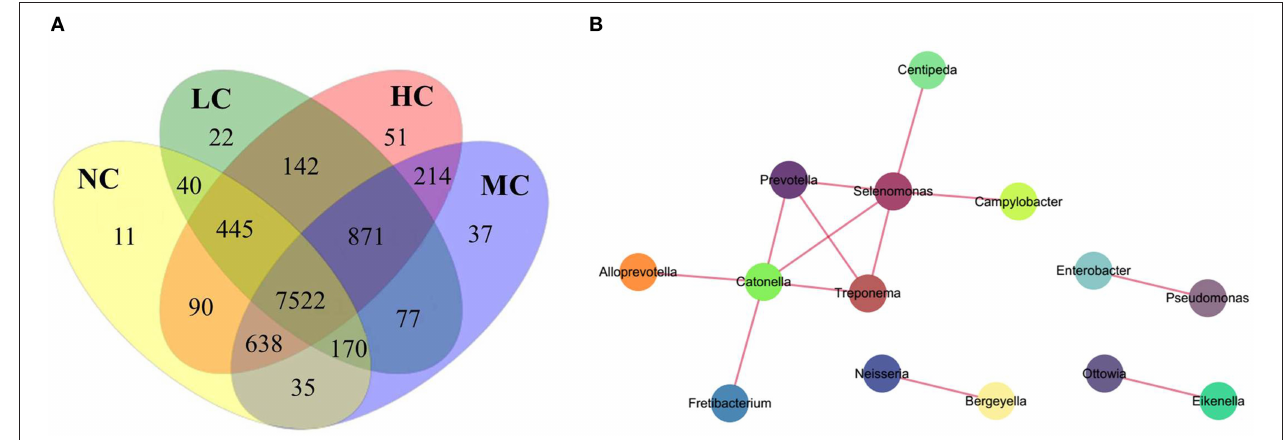
FIGURE 6 | A Venn diagram and network analysis. (A) A Venn diagram showing shared and unique OTUs at 97% identity among the four groups. (B) A network diagram of dominant genera showing positive